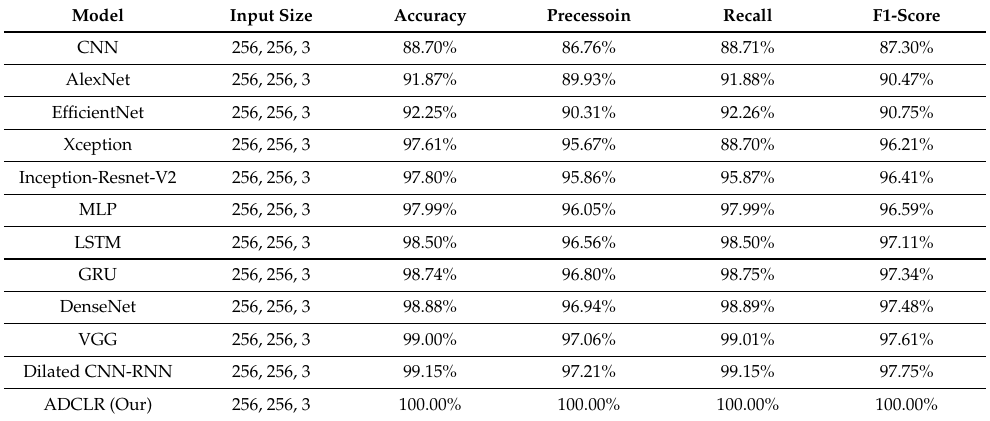
Table 8. Performance comparison of the implemented conventional models with the proposed ADCLR